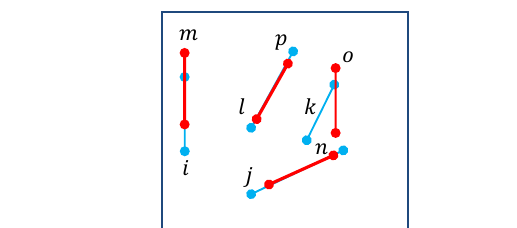
Figure 4. Transformation of all the lines in scan ‘a” to the reference frame of scan “b”